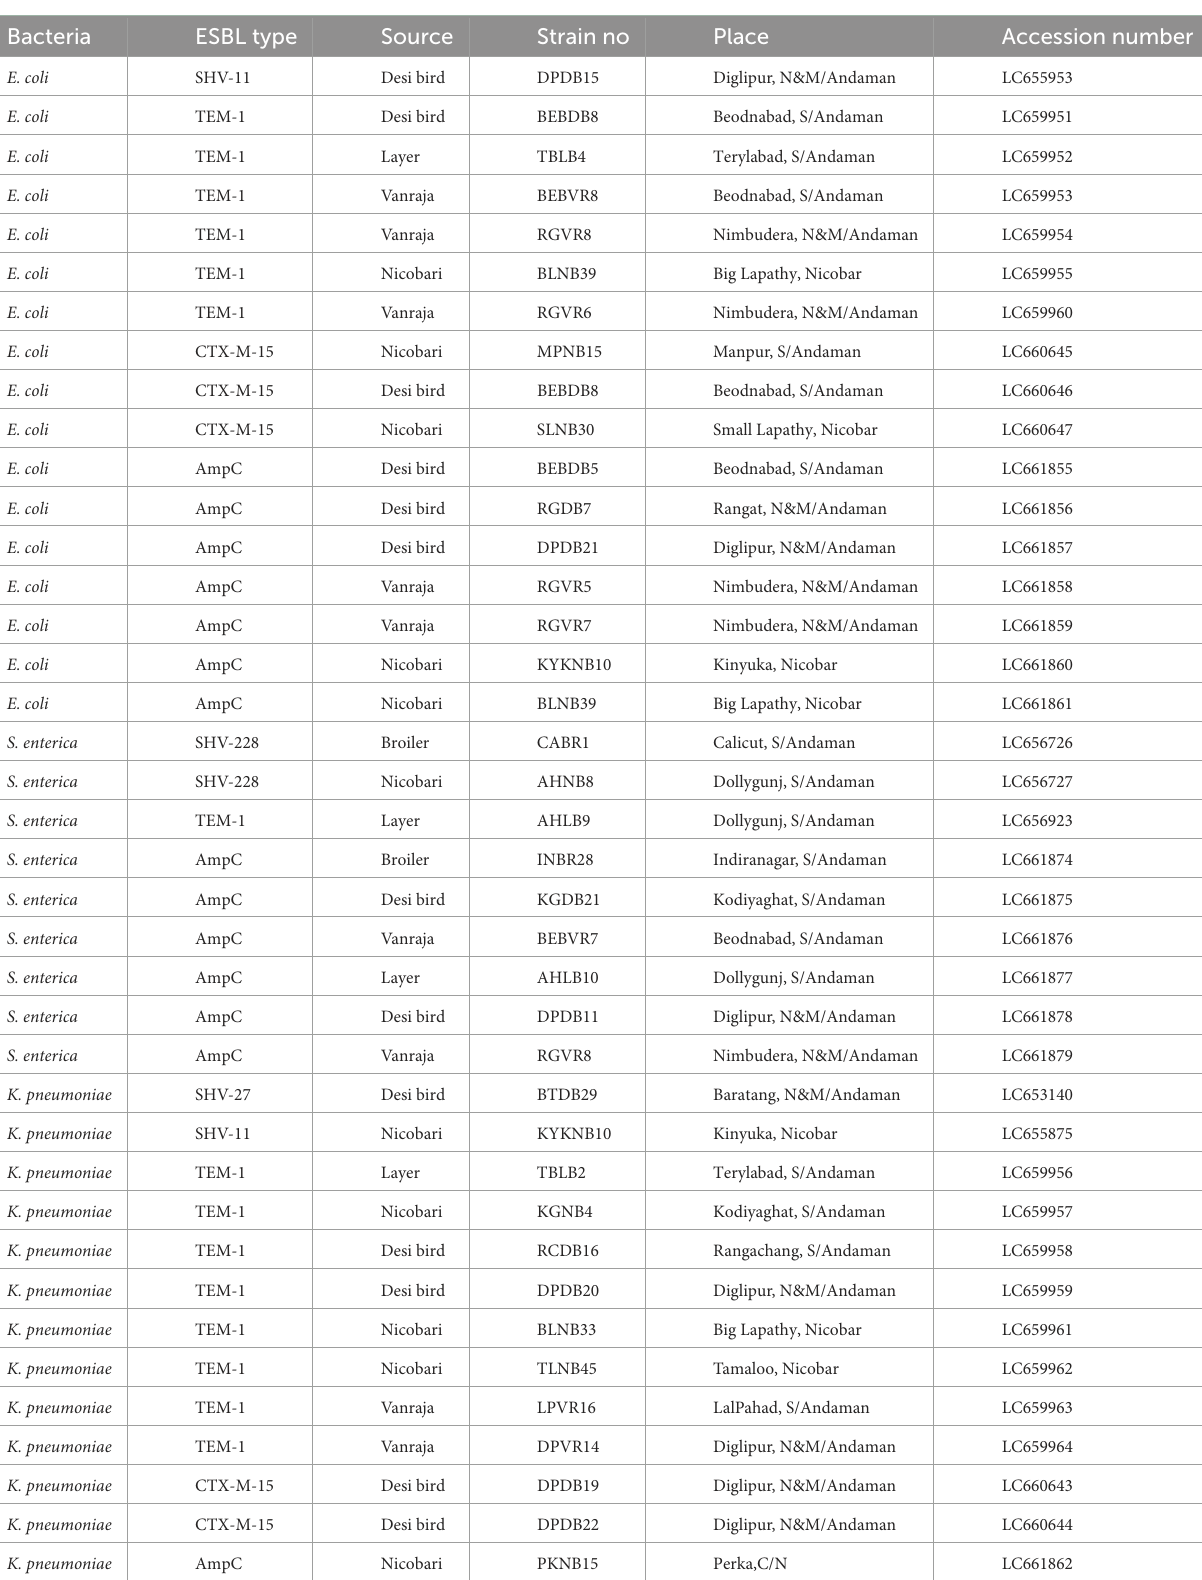
TABLE 3 Accession numbers of nucleotide sequences of ESBL/AmpC genes possessed by E. coli , Salmonella enterica , and Klebsiella pneumoniae strains isolated from different birds in Andaman and Nicobar Islands (India).